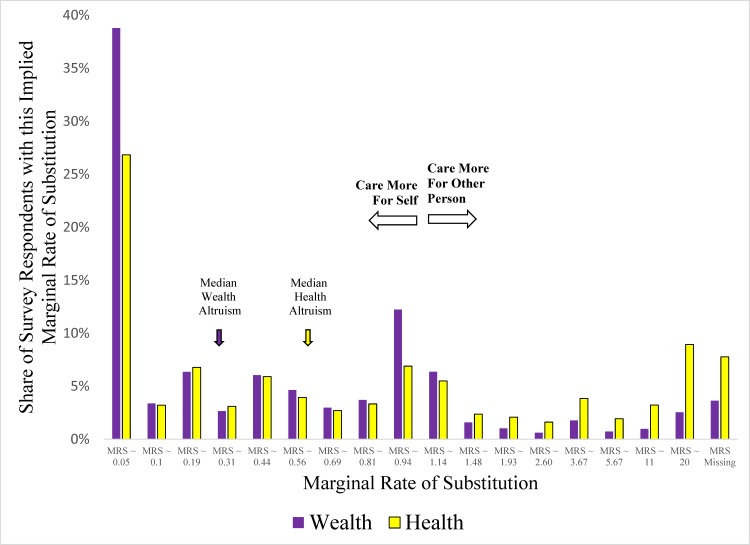
Distributions of levels of health and wealth altruism (survey 2).